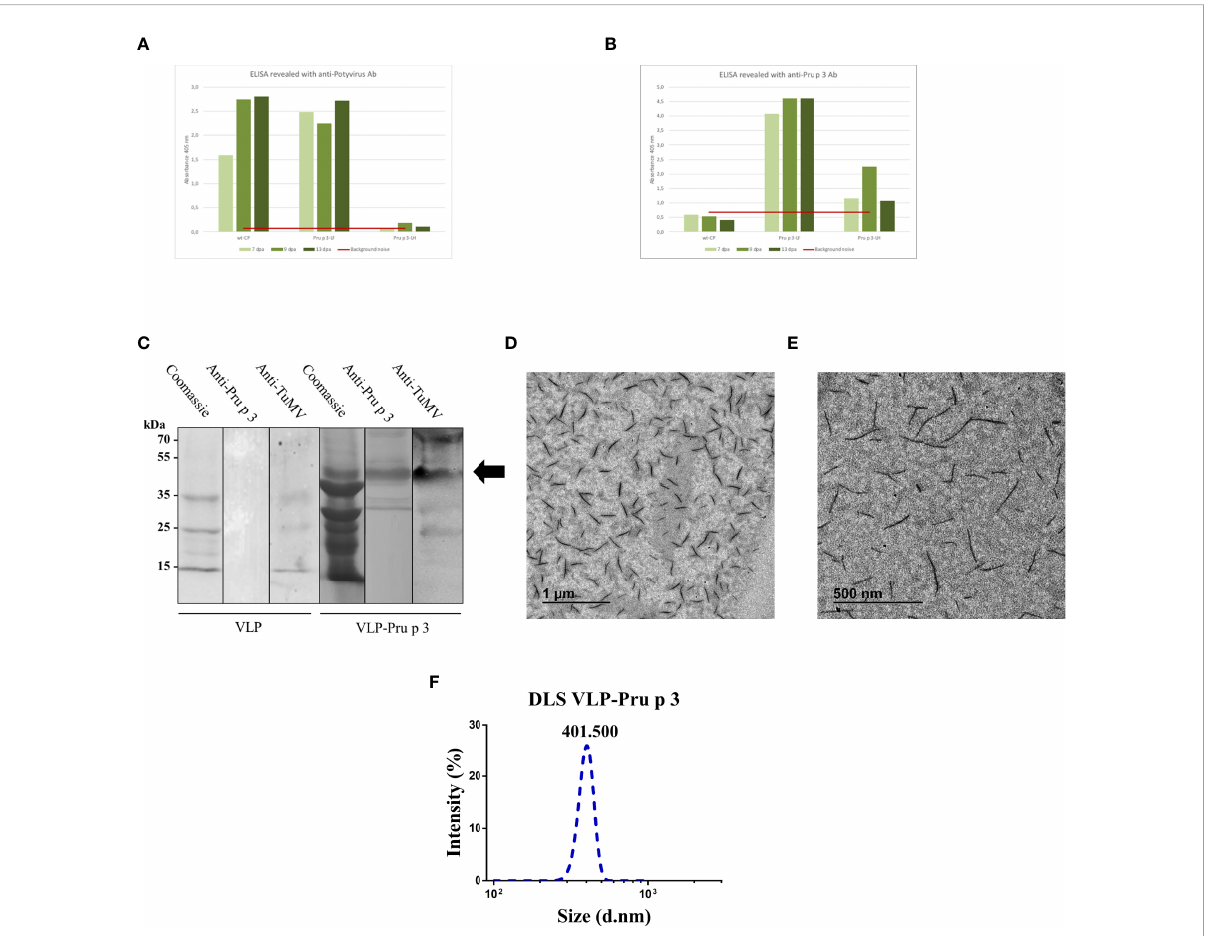
FIGURE 2 Characterization of VLP-Pru p 3 production. ELISA analyses of extracts from Nicotiana benthamiana leaves, using (A) anti-Potyvirus, or (B) anti- Pru p 3 antibodies. Readings at 405 nm are shown of leaves collected at 7, 9, or 13 days post-agroin fi ltration (dpa). Red line (background noise) was calculated as the three-fold absorbance of non-in fi ltrated leaves. (C) Western blot analyses from exclusion chromatography fractions from VLP and VLP-Pru p 3 agroin fi ltrates. (D, E) Representative transmission electron microscope images of VLP-Pru p 3. (F) Representative analysis of VLP-Pru p 3 size and dispersion by DLS. The assay was repeated weekly for 6 consecutive weeks to assess stability of the formulation through